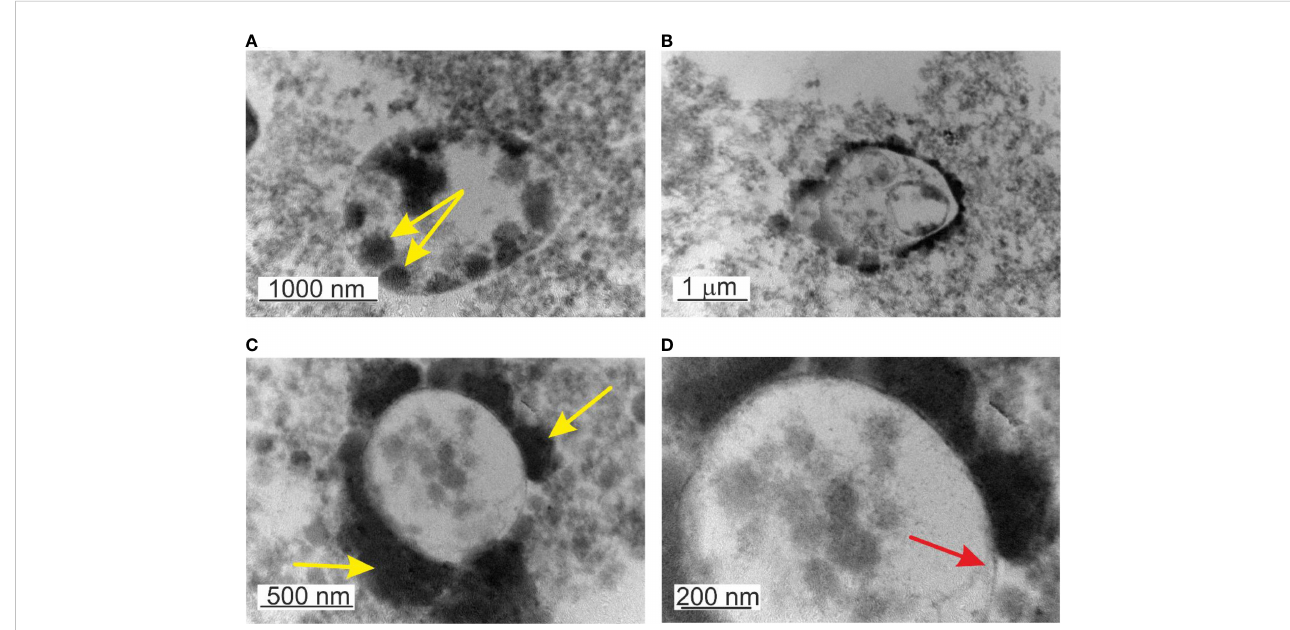
FIGURE 7 TEM images of lysed, non- fi ltered, and cultured blood. (A) Mature cell >2µm fi lled in with elementary cells - yellow arrow. (B) Growth of progeny cells within a progeny cell that grows within the “ mother ” cell (C) Formation of thick capsular material on the external side of the membrane or attached elementary cells. (D) Microbial-like structures delimited by a membrane – red arrow.